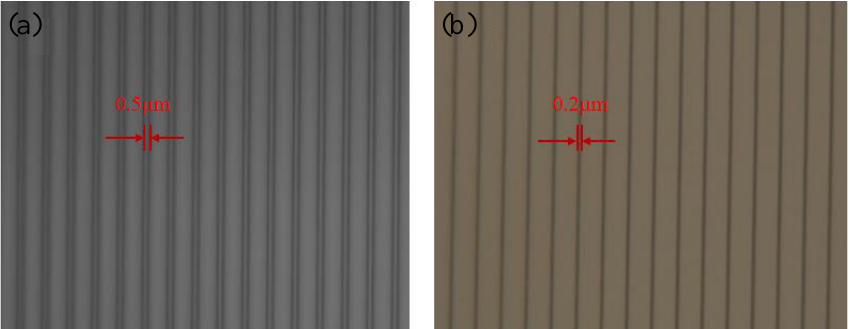
Figure 8. Images of ( a ) photoresist stripes before the etching process; ( b ) SiO 2 stripes after photoresist removing.